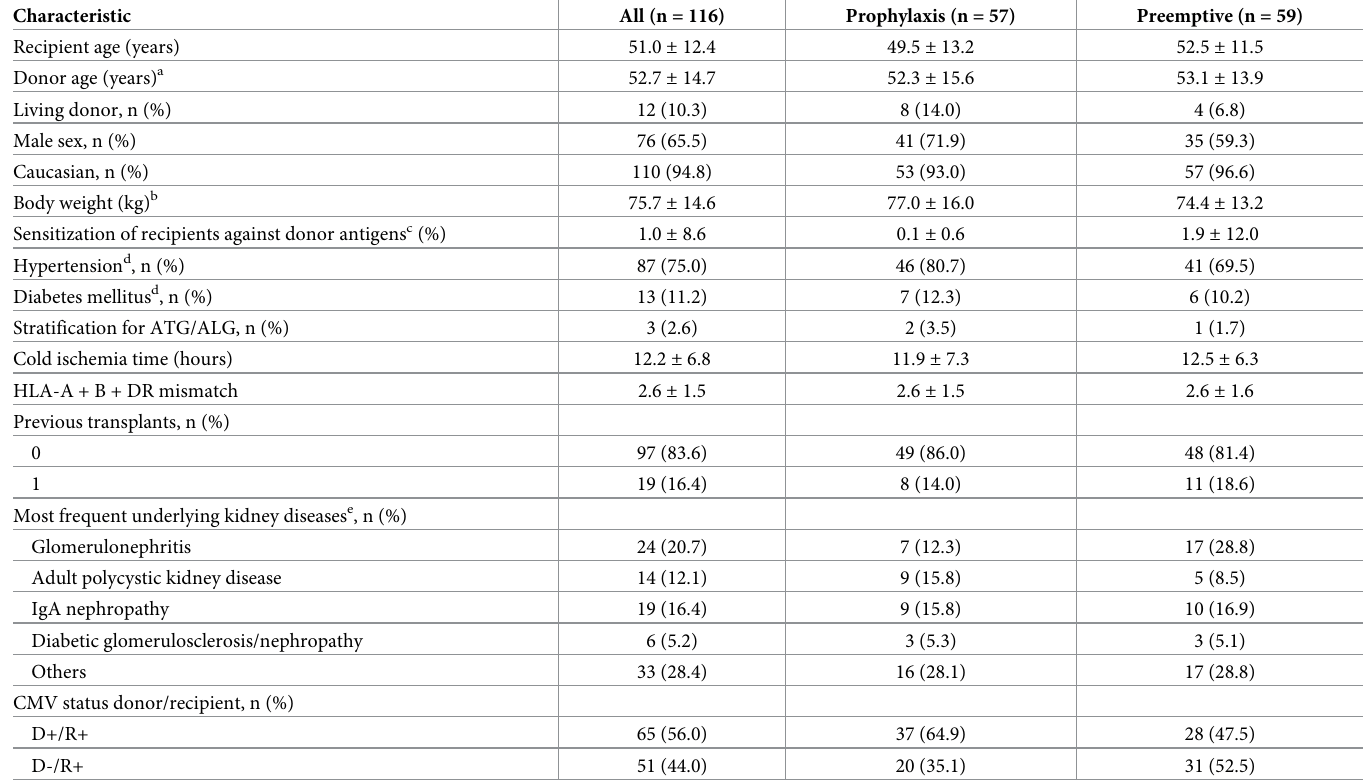
Table 1. Demographic and clinical characteristics at